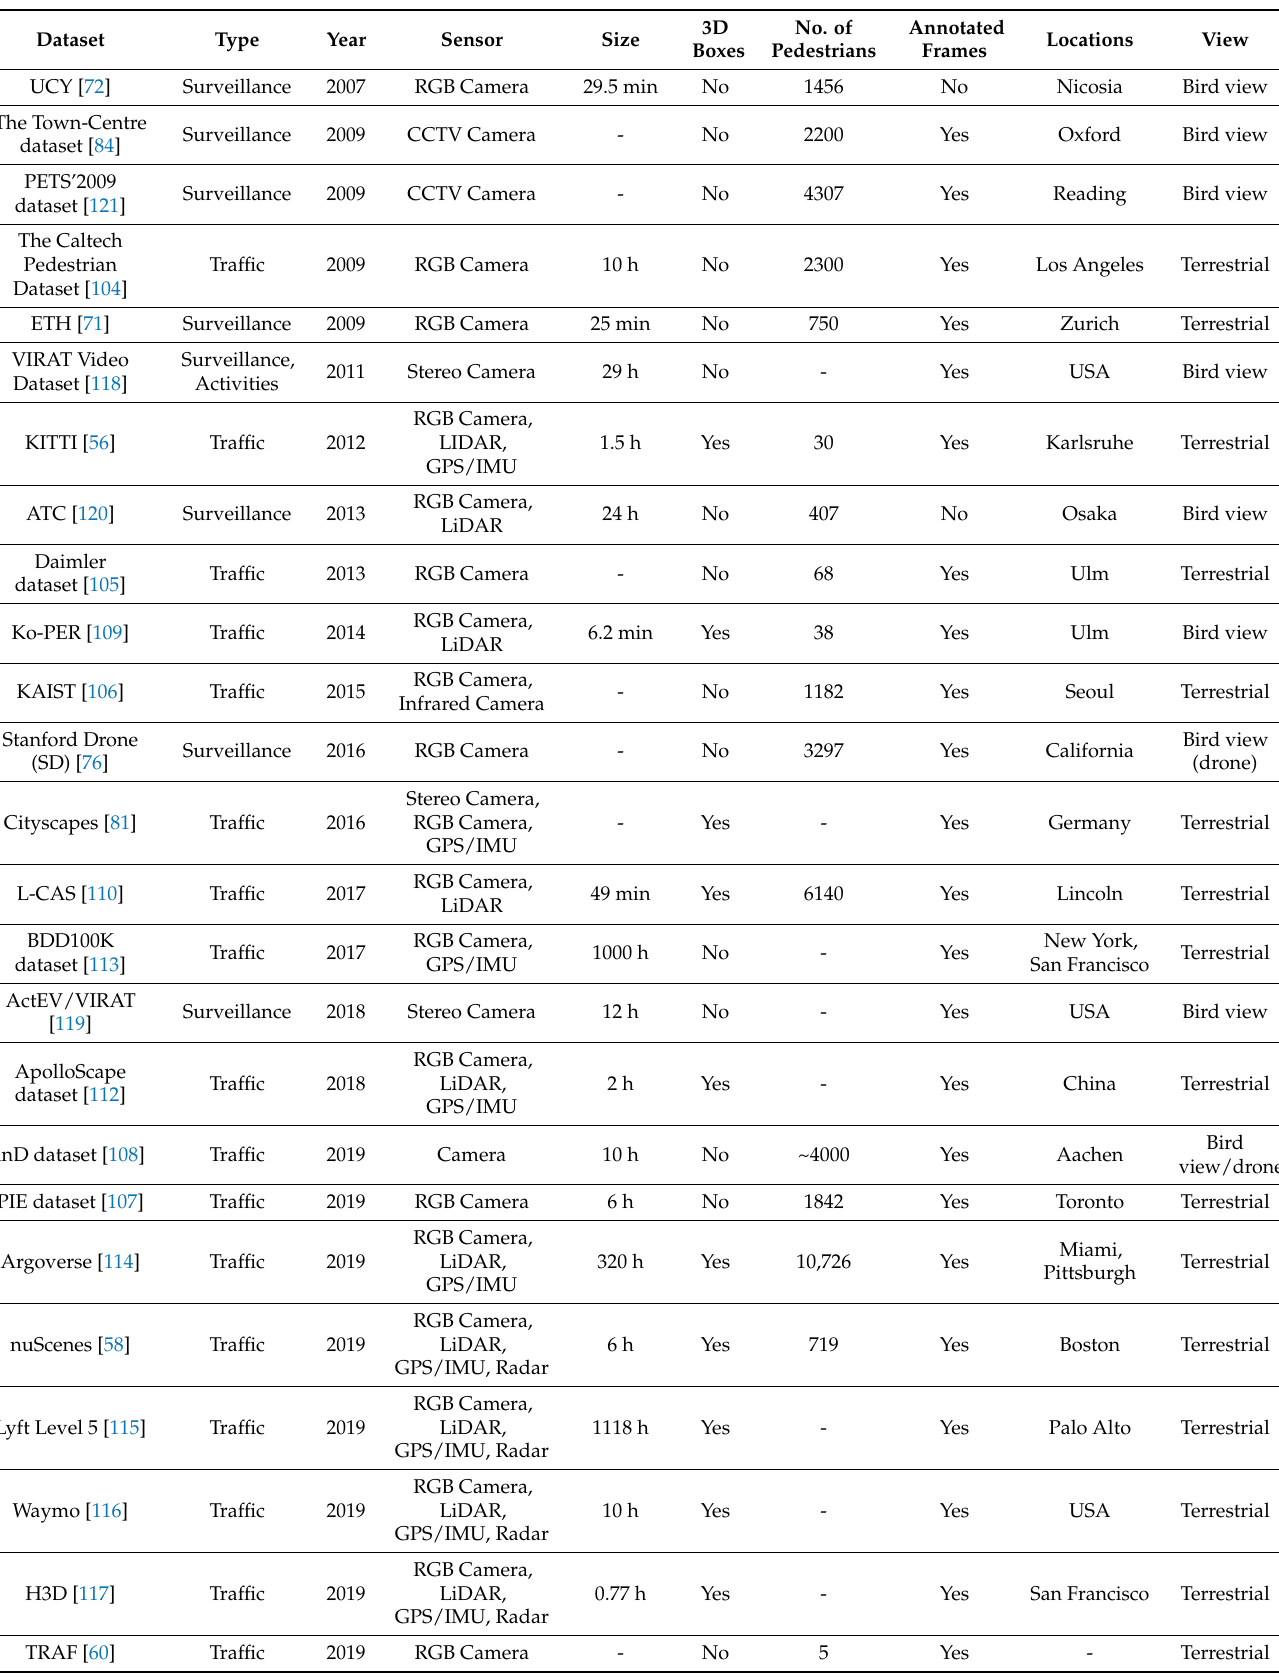
Table 3. Overview on available datasets divided by type, publishing year, location,